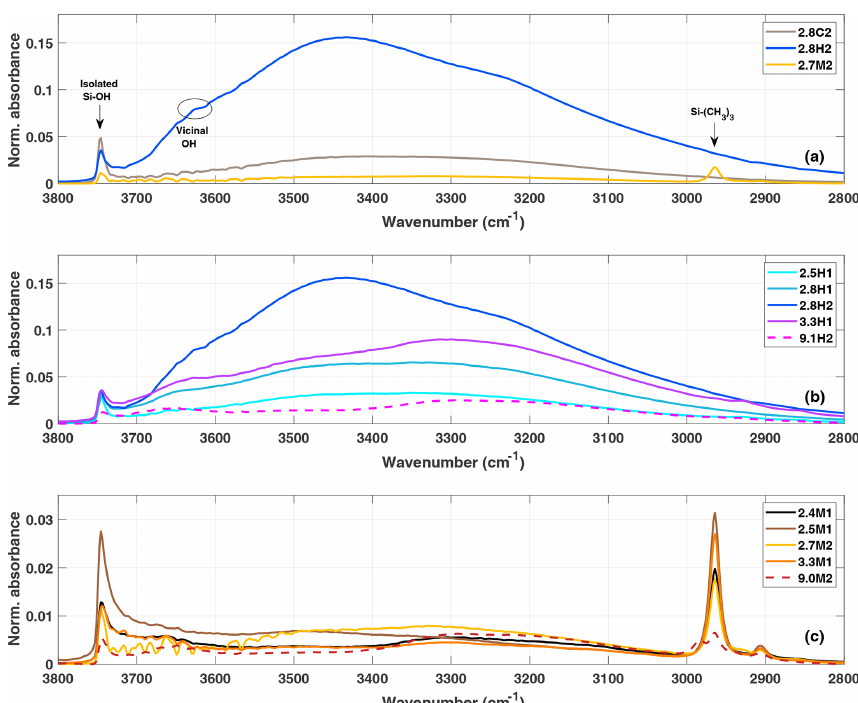
Figure 3. (a) DRIFTS normalized absorbance (Kubelka–Munk) for the 2.8nm particles after calcination (grey), hydroxylation (blue) and methylation (gold). Panels (b) and (c) show the spectra of hydroxylated and methylated samples,